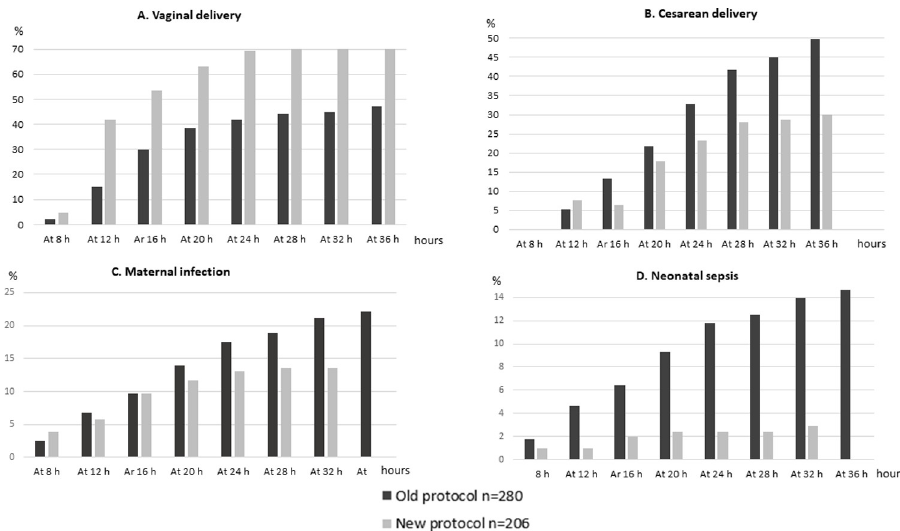
Fig 3. The rates of vaginal delivery, cesarean delivery, and maternal and neonatal infections during the old and new oxytocin protocols.